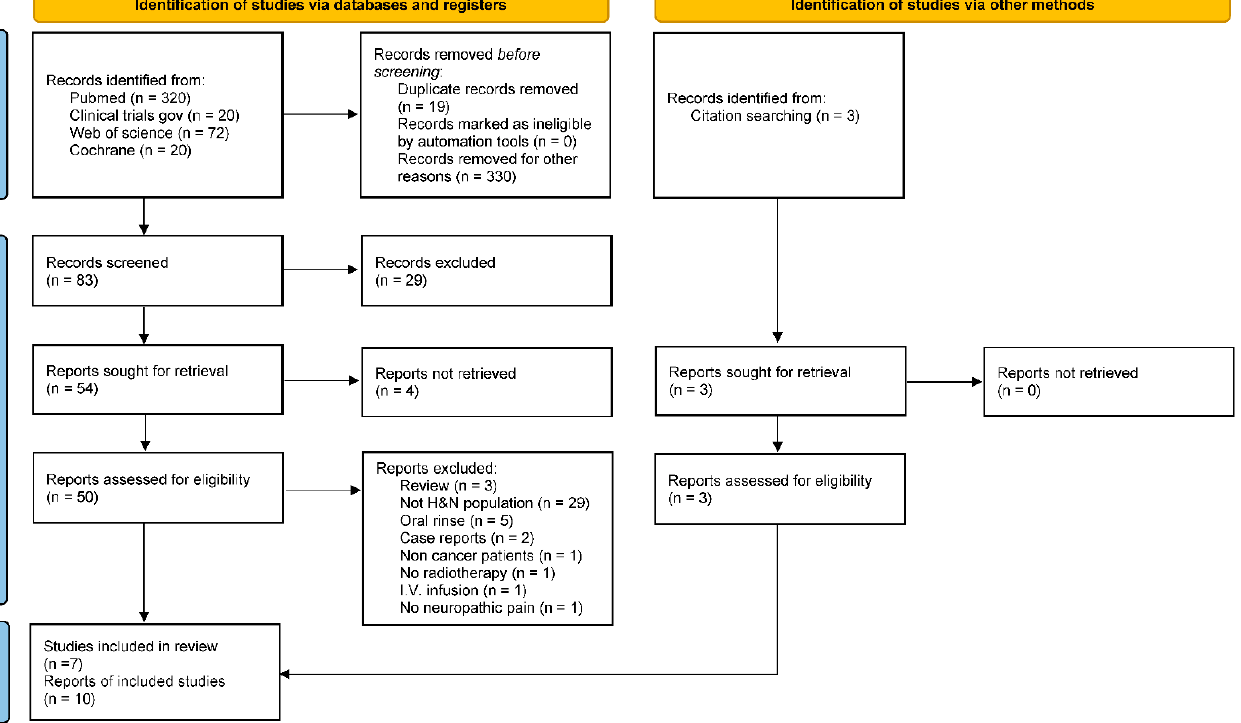
Figure 1. PRISMA 2020 flow diagram.